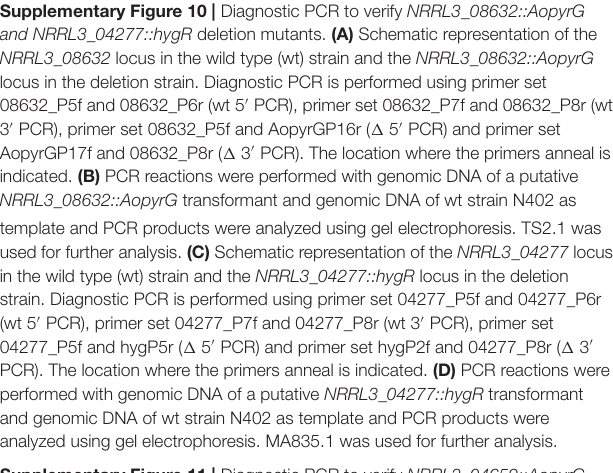
Supplementary Table 1 | Overview of the primers used in this study. Supplementary Table 2 | TPM expression values. Supplementary Table 3 | Gene clusters higher expressed in 1 tanX . Supplementary Table 4 | Expression values of genes encoding ring cleavages